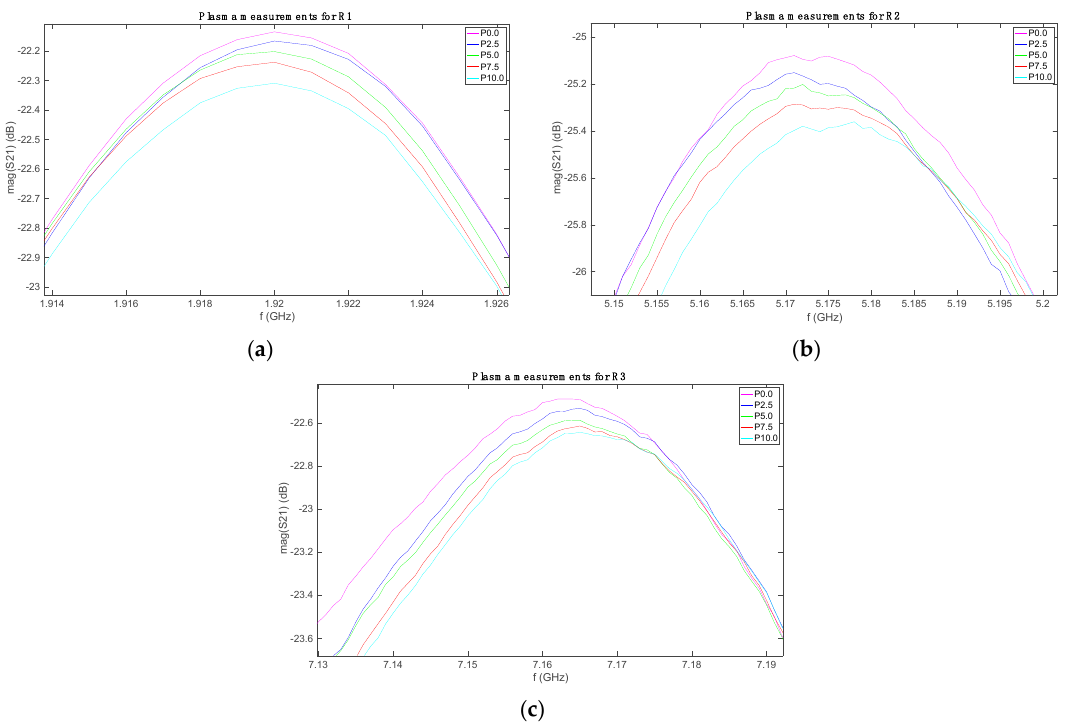
Figure 3. ( a ) Measured S21 parameter for plasma set with R1; ( b ) Measured S21 parameter for plasma set with R2; ( c ) Measured S21 parameter for plasma set with R3. R1, R2, and R3 are microstrip open-loop half-wave resonators with resonant frequencies of 2 GHz, 5.7 GHz, and 8 GHz, respectively.